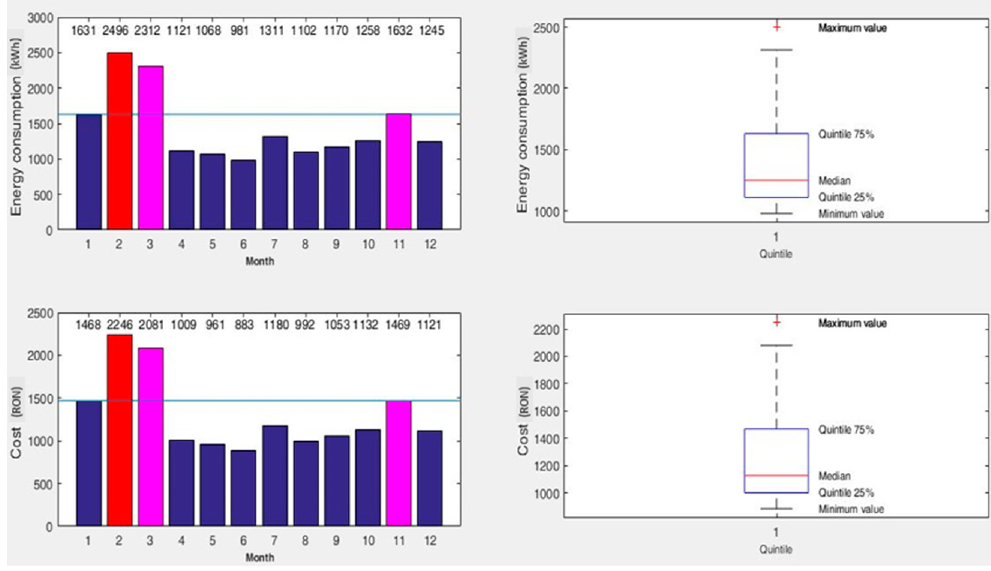
Figure 10. The boxplot of the monthly energy consumption from 2019.